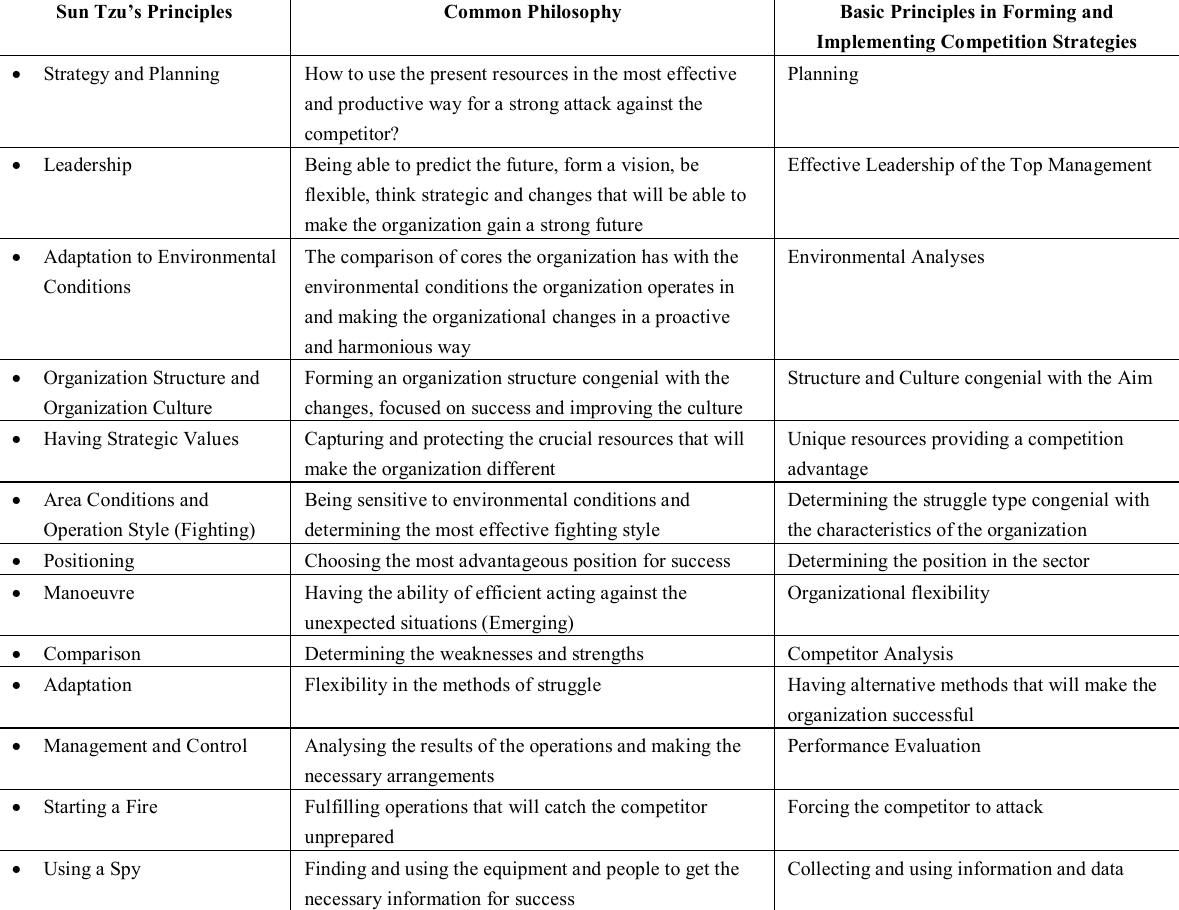
Table 5: Sun Tzu’s War Art Principles and Competition